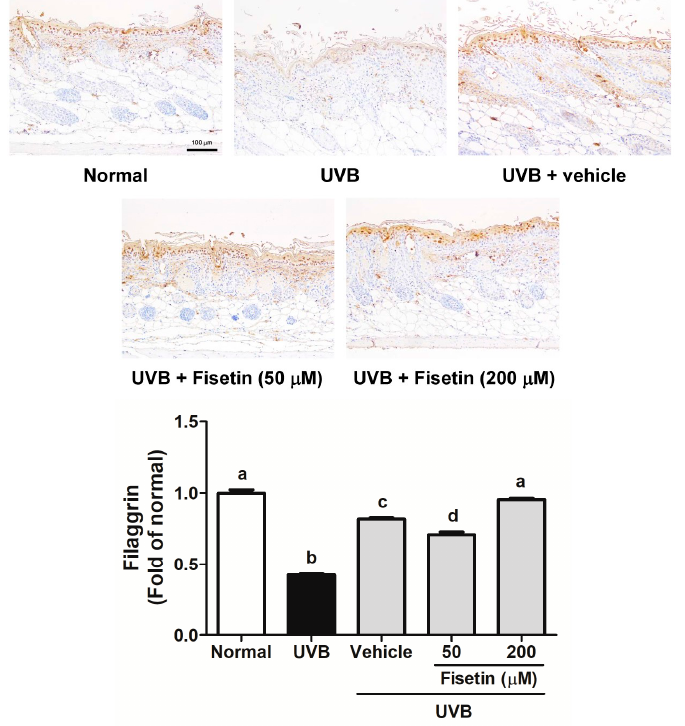
Figure 14. Immunohistochemical staining of filaggrin expression in the epidermis of mouse skin slices. Fisetin increases filaggrin overexpression (200×). a–d: Values not followed by a common letter are significantly different ( p < 0.05).